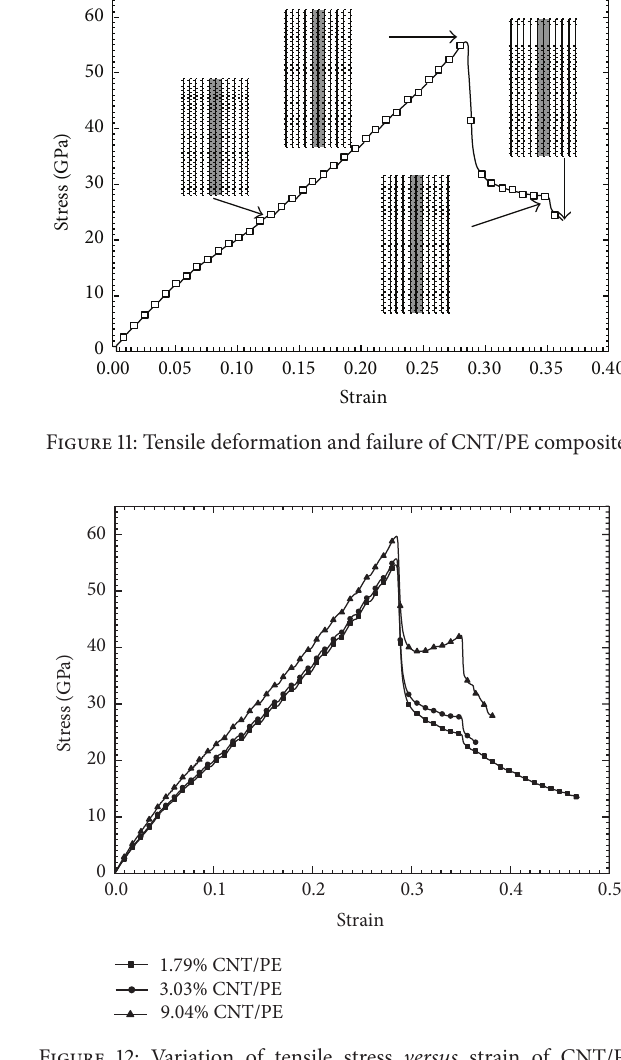
Figure 12: Variation of tensile stress versus strain of CNT/PE composites with different volume